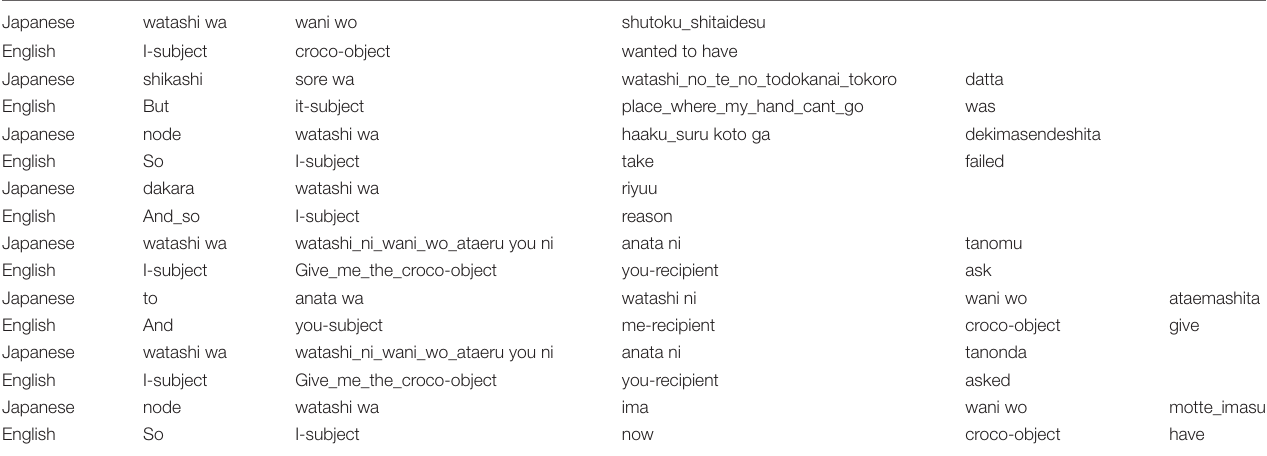
TABLE 11 | Correspondence between Japanese and English